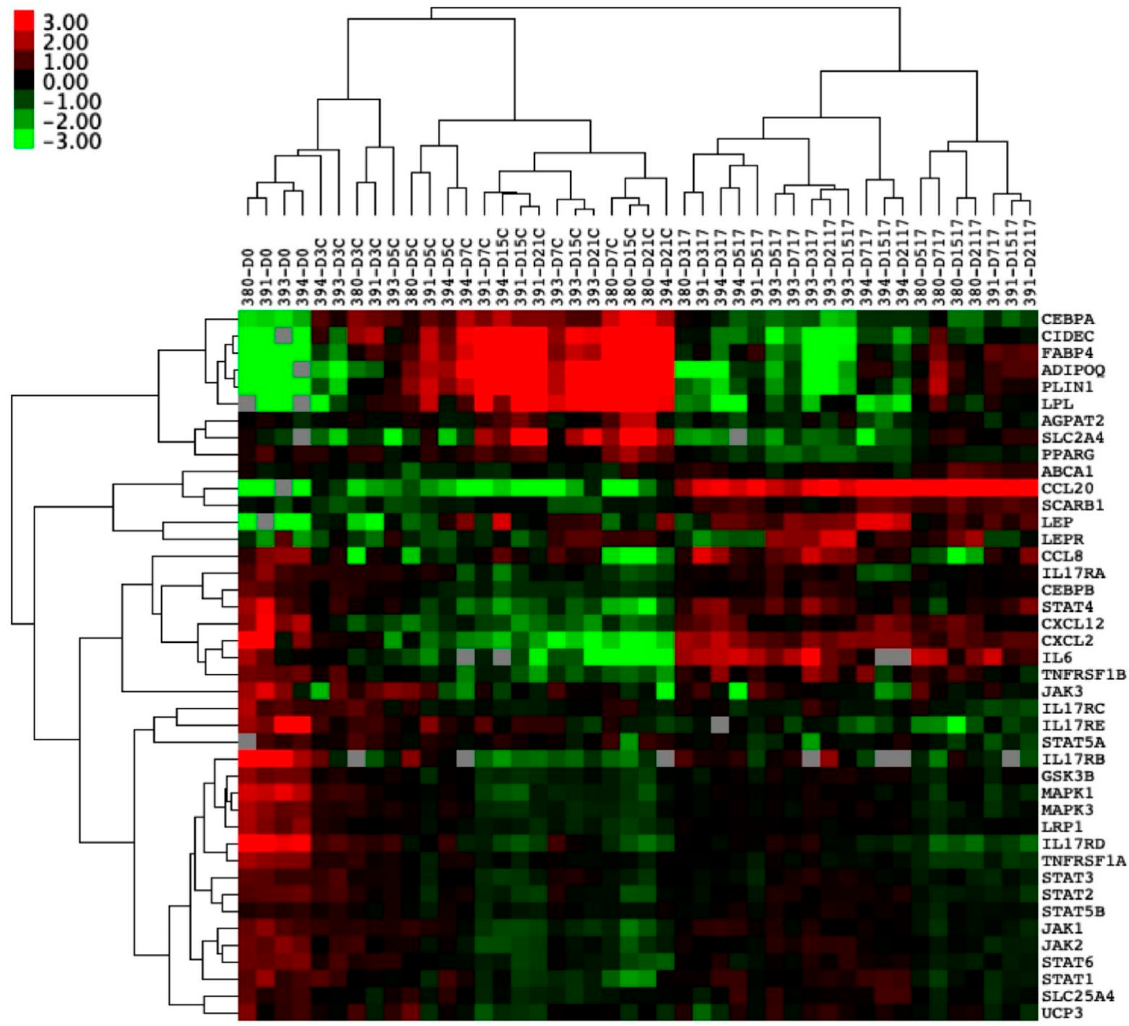
Figure 4. Entheseal soft tissue (EST) mesenchymal stem cells (MSCs) ( n = 4) undergoing 21-day adipogenesis ± IL-17A. Hierarchical clustering demonstrating the distinct clustering of unstimulated MSCs undergoing adipogenesis away from MSCs stimulated by IL-17A. Colour denotes the relative expression of Hypoxanthine Phosphoribosyltransferase 1 ( HPRT1) , with green representing low, black representing equal, red representing higher, and gray representing below detection. Numbers denote the sample ID, and D indicates the days in culture. IL-17A used at 50 ng/mL.